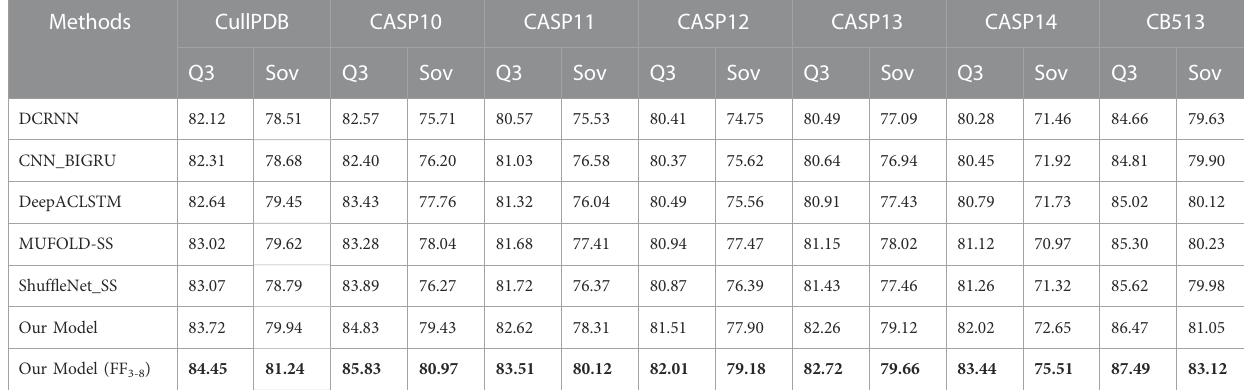
TABLE 5 3-state PSSP performance comparison with state-of-the-art methods on seven datasets. Bold indicates the best performance. Methods CullPDB